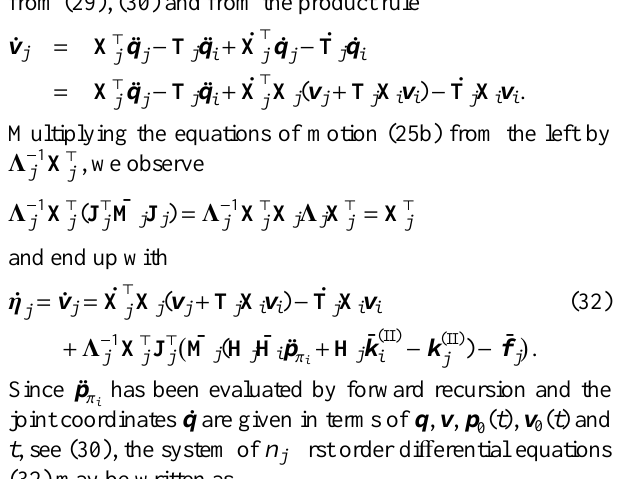
Figure 3. Two planar configurations illustrating the analysis of Sect. 3, see Arnold et al.